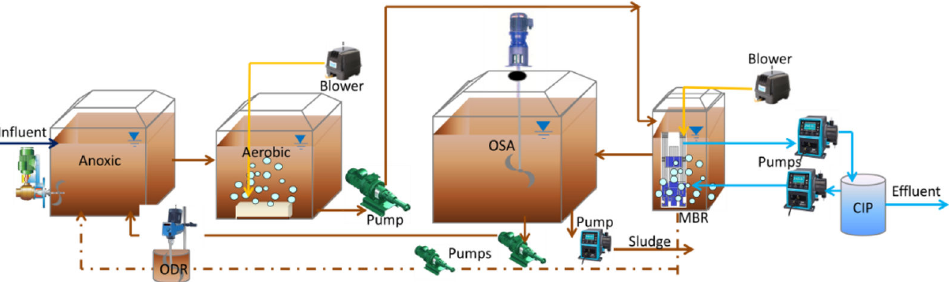
Figure 5. MBR-OSA pilot plant